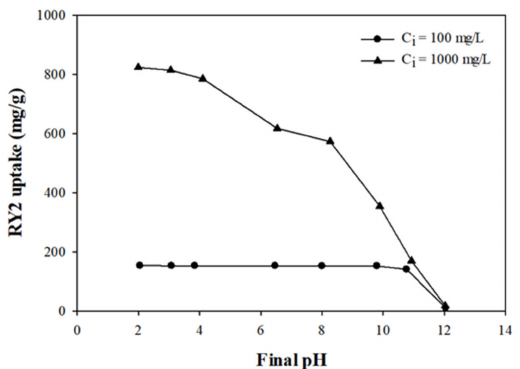
Figure 4. The effect of pH on RY2 adsorption by PEI/PVC-CF at the initial dye concentrations of 100 and 1000 mg/L (experimental conditions: m = 0.02 g, V = 30 mL, pH range = 2.0–12.0, and temperature = 25 ◦ C).